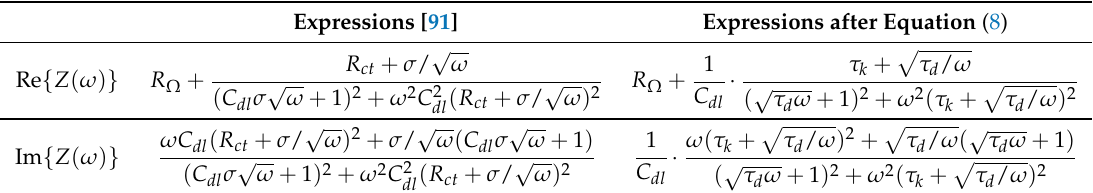
Table 3. Expressions of the real and imaginary parts of the electrochemical impedance of the Randles circuit in Figure 5.